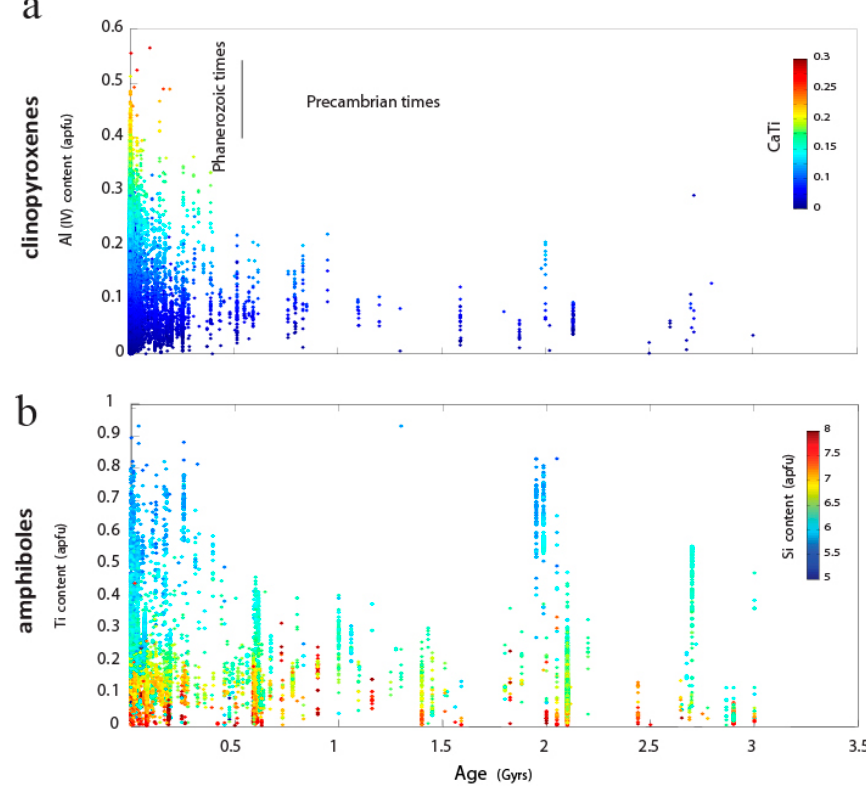
Figure 3. ( a ) Chemical evolution of clinopyroxene (Al 4+ a.p.f.u. and CaTi end member component) according to their age (16,683 analyses). The data illustrates an increase in high-Ti and high-Al clinopyroxene occurrence in magmatic systems, from ca. 1 Gyr to present day, following a ~1 Gyr period dominated by low-Ti and low-Al clinopyroxenes. ( b ) Chemical evolution of amphibole (Ti and Si a.p.f.u.) according to their age (11,218 analyses). The data illustrates an increase in high-Ti and low-Si amphibole occurrence in magmatic systems, from ca. 1 Gyr to present day, following a ~1 Gyr period dominated by low-Ti and high-Si amphiboles.